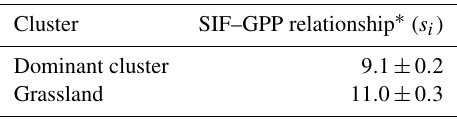
Figure 2. Identifying distinct SIF–GPP relationships across ecosys- tems. Histogram shows the distribution of slopes that map SIF to GPP using a bisquare regression and a 2000-member bootstrap. Colors denote the different ecosystems, and triangles at the bot- tom show the mean for that ecosystem. Gray distributions are from a two-member Gaussian mixture model, and the stars indicate the mean for that component. Table 1. SIF–GPP relationships for different